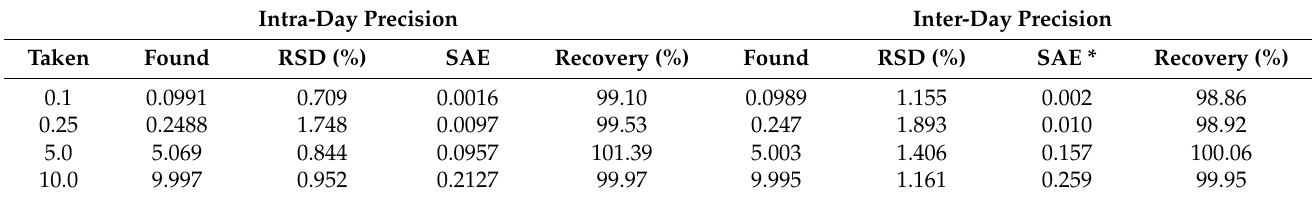
Table 3. Accuracy and precision study for the determination of MG.